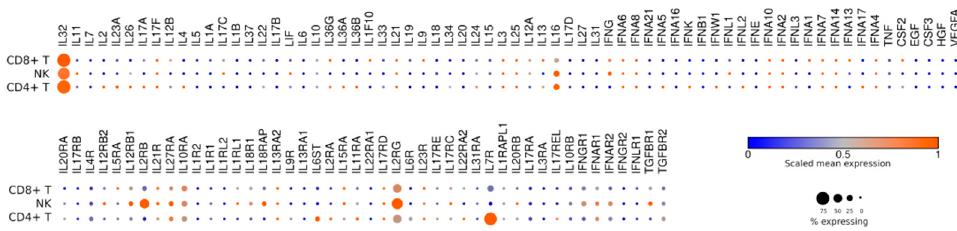
Figure 1. Expression plot for cytokine receptors and cytokine-encoding genes across the major subpopulations of human T and NK cells.